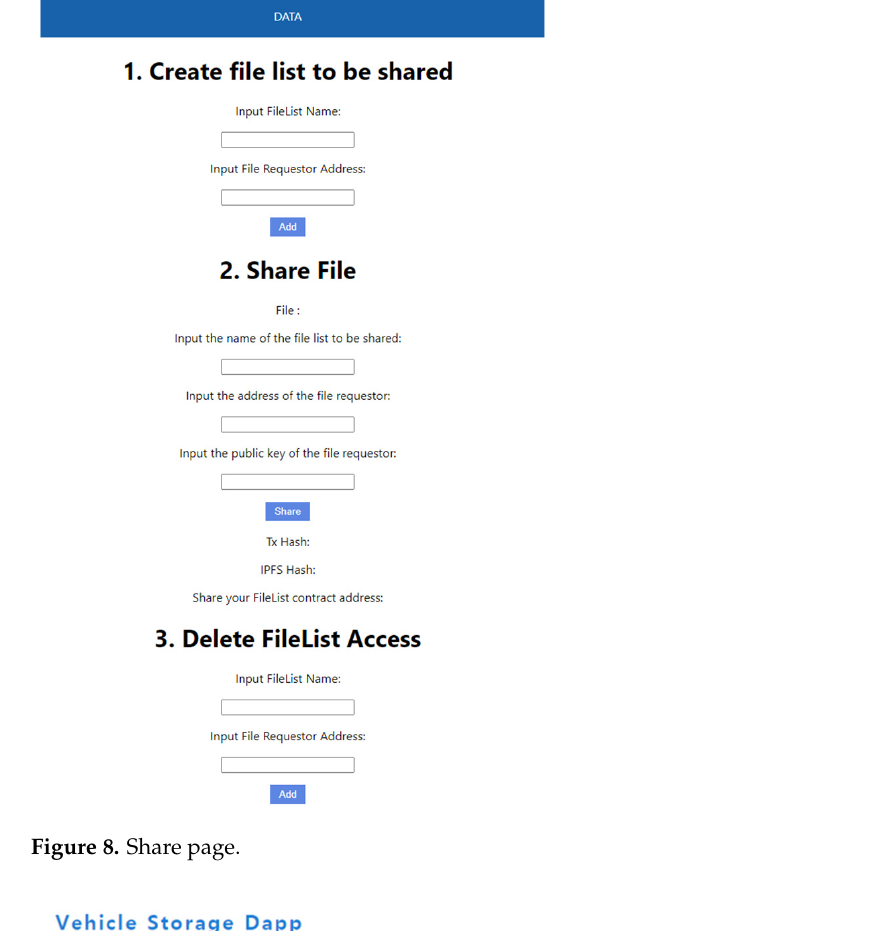
Figure 8. Share page.